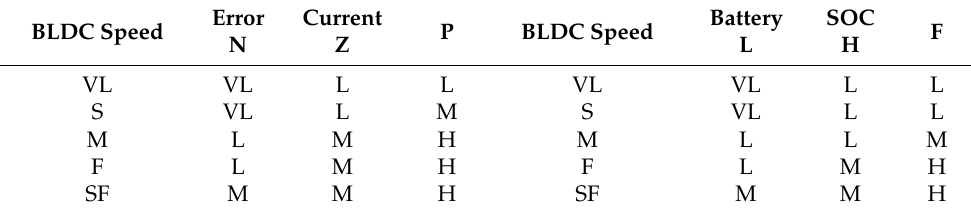
Table 7. Rules for the Proposed FLC.